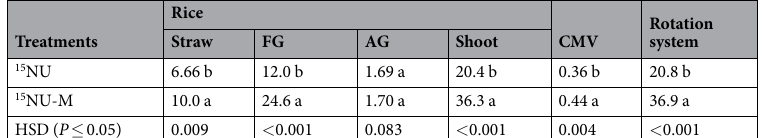
Table 3. The 15 N recovery by shoots of rice and CMV plants in the rice-based rotation system (%). 15 NU: 15 N-labeled urea as FN alone, 15 NU-M: substituting partial 15 N-labeled urea with CMV as GM. FG: filled grain, AG: abortive grain. Different letters within the same column indicate significant differences among treatments according to Tukey’s test at P ≤